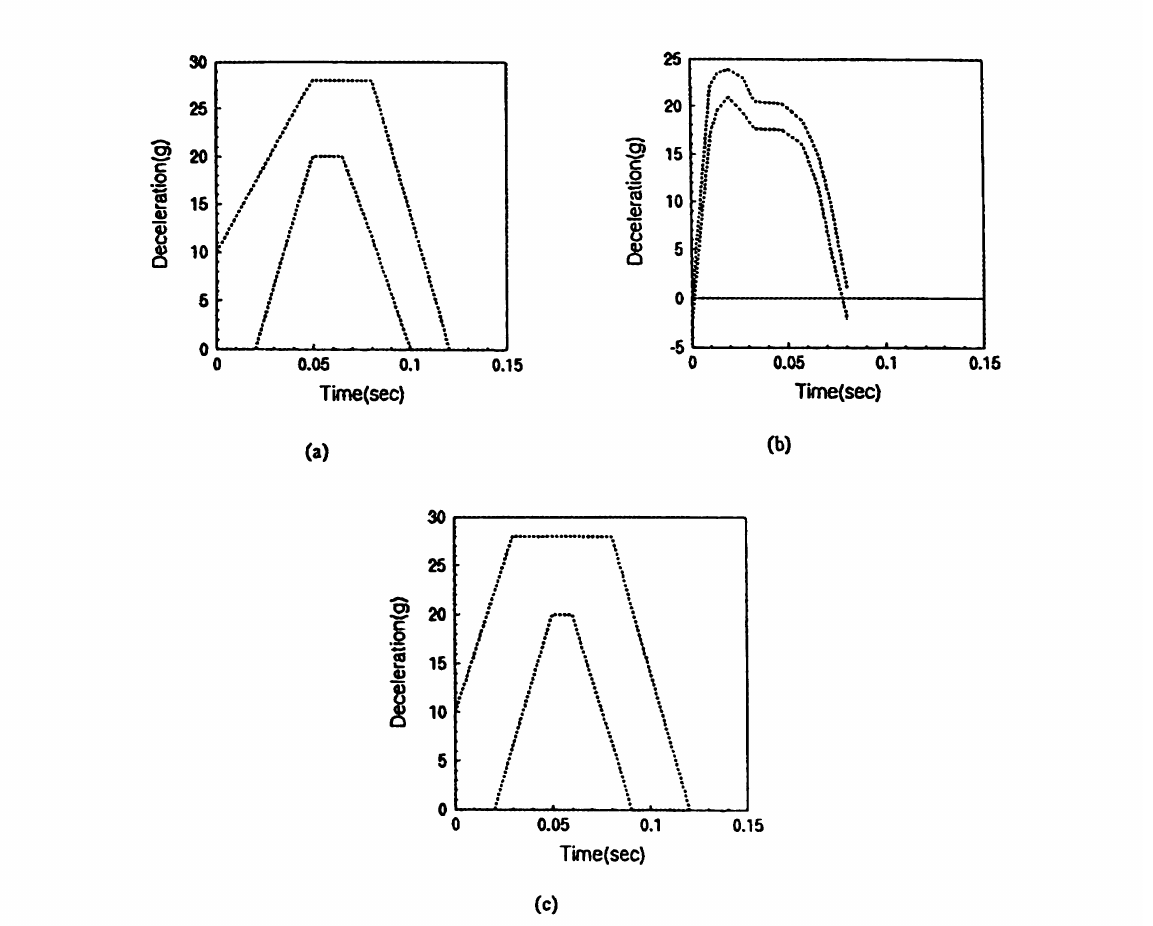
FIGURE 2 Child seat corridors: (a) ECE R44; (b) FMVSS 213; (c) JIS